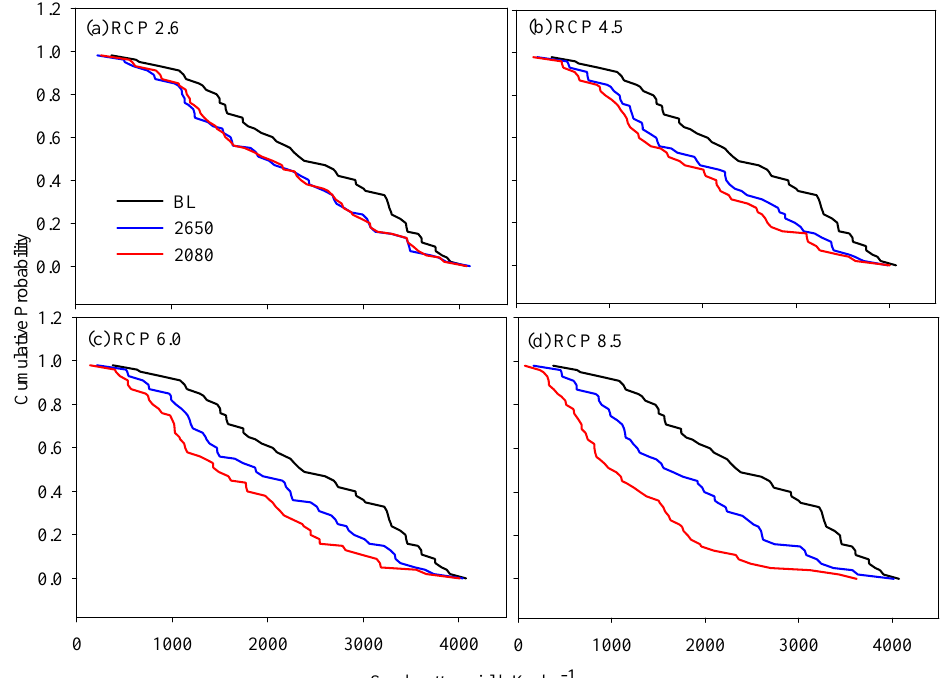
Figure 11. Simulated impacts of temperature rises in 2050 and 2080 alone on rainfed seed cotton yield under RCP 2.6 ( a ), 4.5 ( b ), 6.0 ( c ), and 8.5 ( d ) emission scenarios. Projected changes in both maximum and minimum temperatures alone were considered assuming no CO 2 and rainfall changes. (a) RCP 2.6